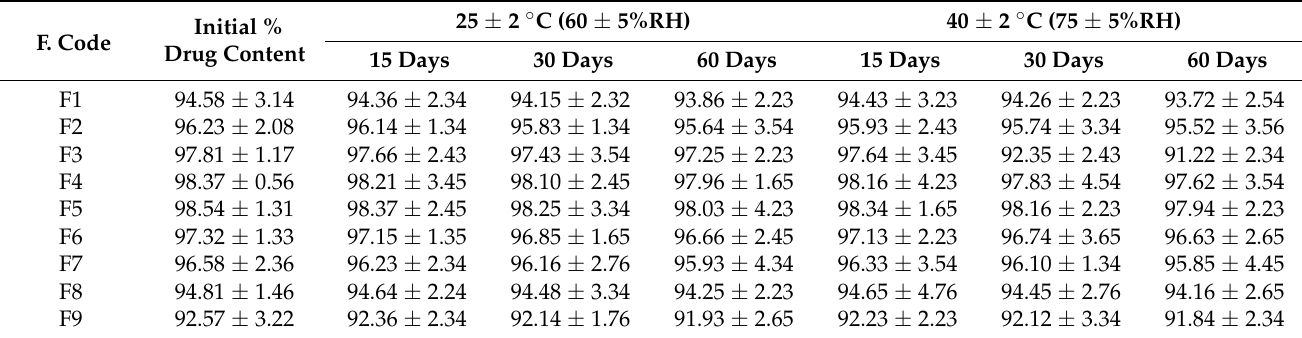
Table 3. Stability studies of methotrexate patches.